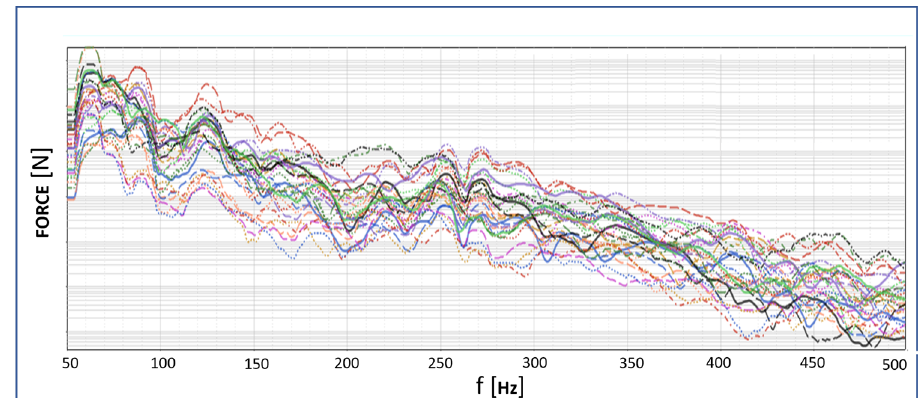
Figure 36. Real force spectrum at the suspension points, corresponding to the pave track.